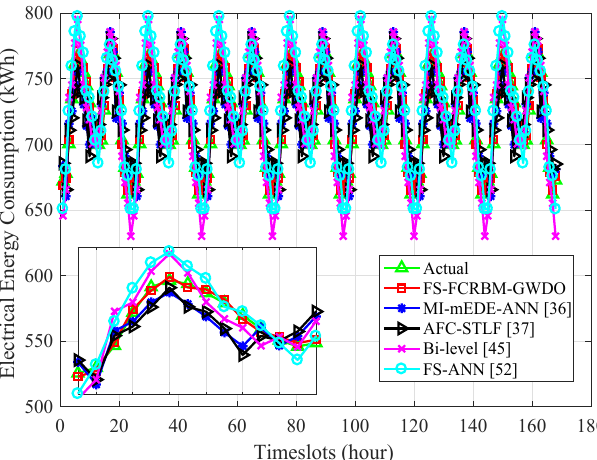
Figure 9. Week ahead electrical energy consumption forecasting of FE power grid with hour resolution.